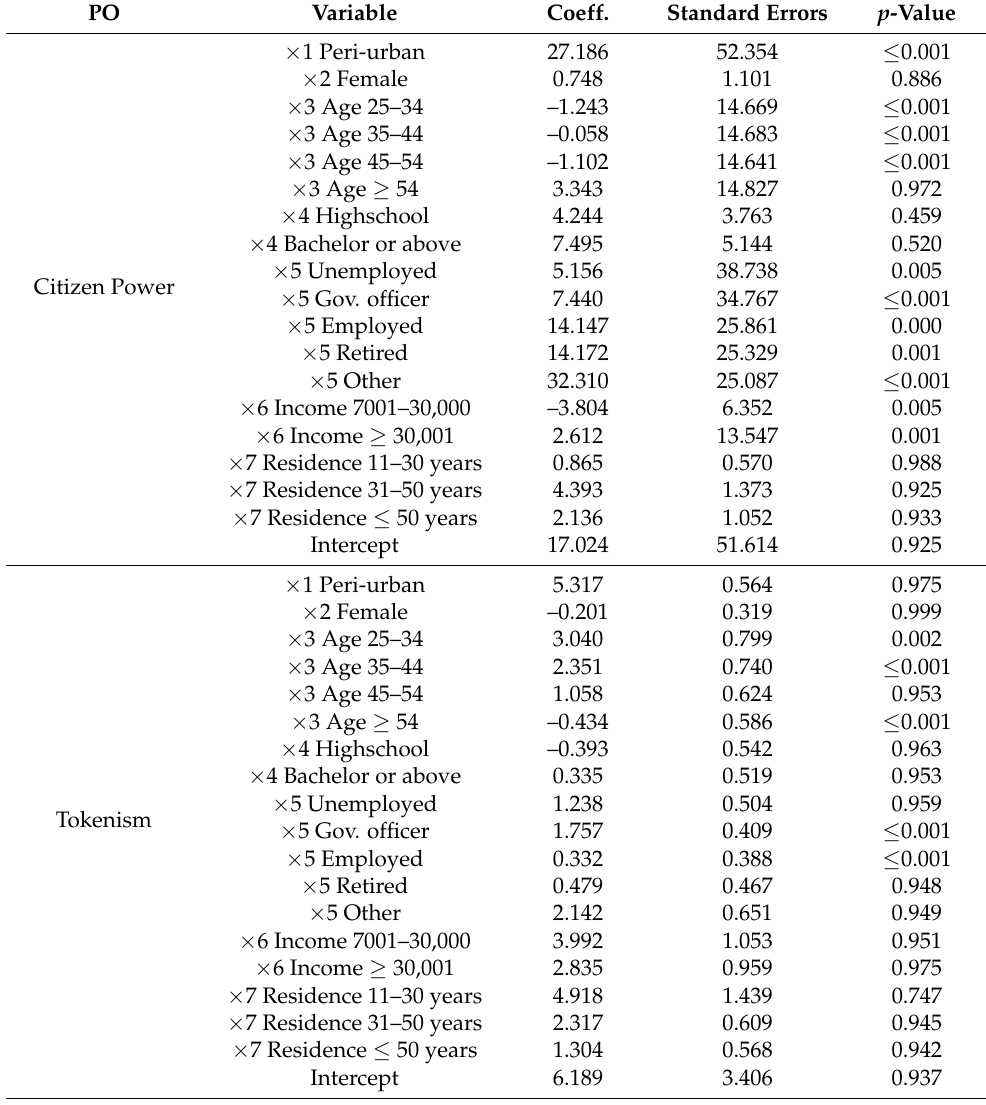
Table 4. Sociodemographic factors influencing citizen participation: multinomial logistic regression (n =